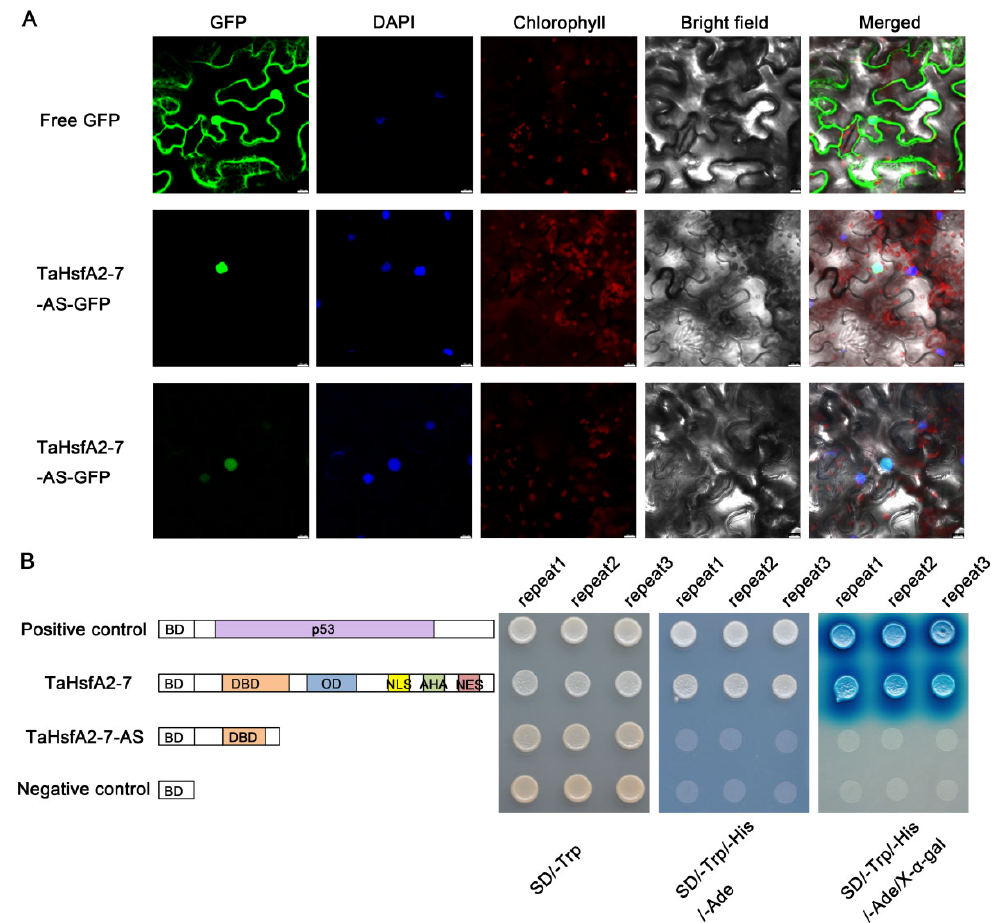
Figure 3. Subcellular localization and transcriptional activity analyses of TaHsfA2-7-AS. ( A ) Subcellular localization of TaHsfA2-7-AS in tobacco leaf epidermal cells. The 35S::GFP (control) and 35S::TaHsfA2-7-AS-GFP were transformed into tobacco leaf epidermal cells and visualized by DAPI staining. Bars = 10 µ m. ( B ) Transcriptional activation analysis of TaHsfA2-7-AS in yeast. Fusion proteins of the GAL4 DNA-binding domain (BD) and TaHsfA2-7 or TaHsfA2-7-AS were expressed in the yeast strain AH109. The transformed yeast cells were spotted onto SD/-Trp and SD/-Trp/-His/-Ade media. The plates were incubated at 30 ◦ C for 3 days. The pGBKT7 and pGBKT7-P53 vectors were used as negative and positive controls, respectively.